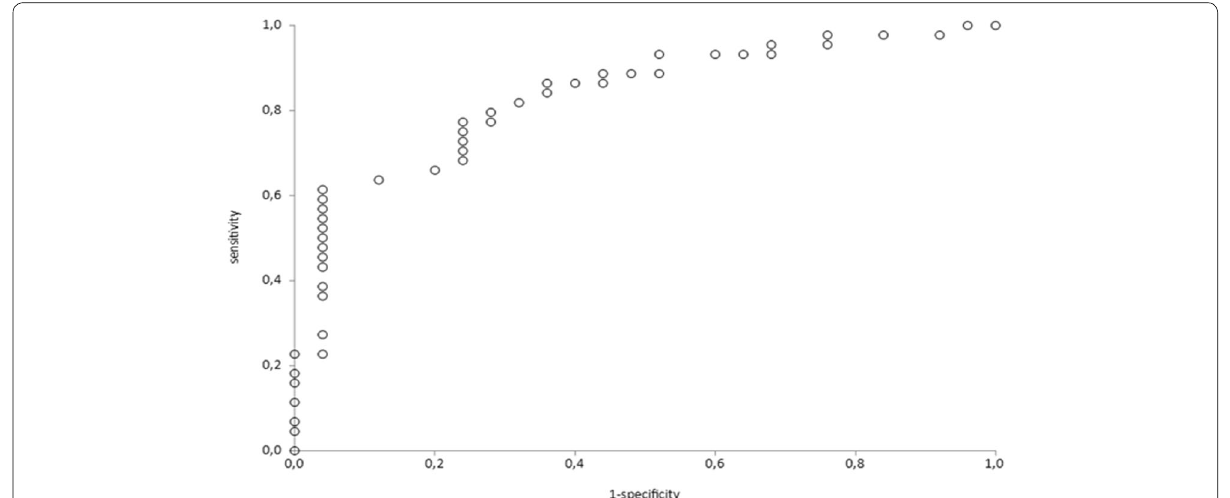
Fig. 4 ROC curve for predictive value of TI plus LUSm in successful weaning (SW). AUC 0.83